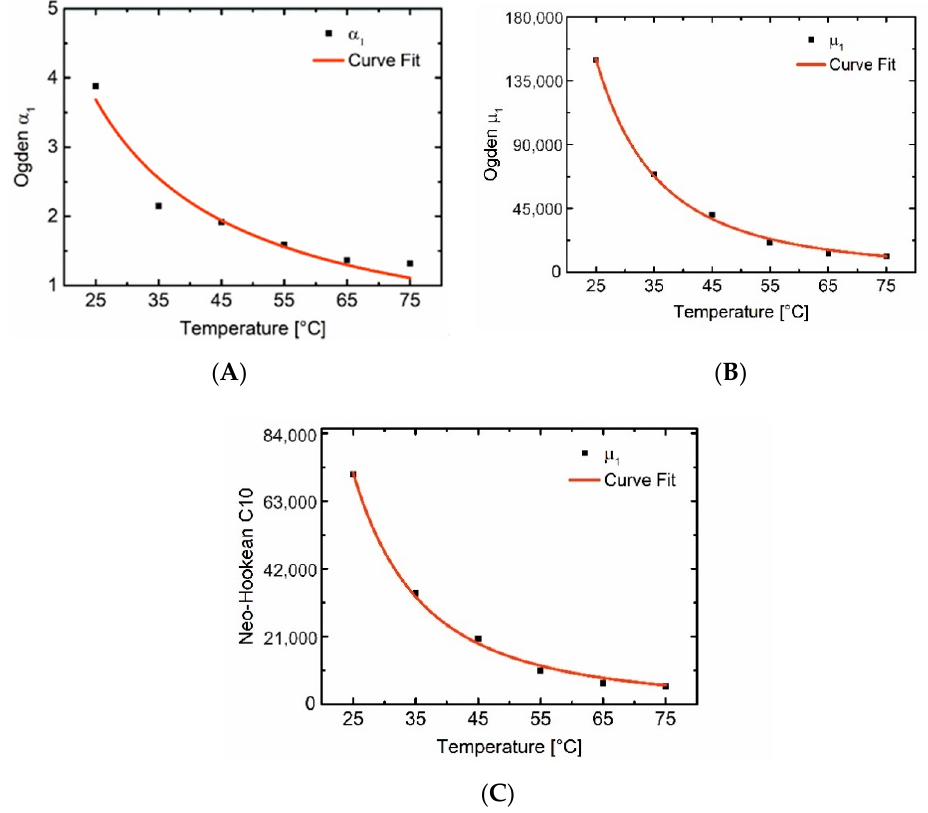
Figure 7. Temperature dependency of model parameters and the fitted power function for Ogden parameters α 1 ( A ) and µ 1 ( B ), and Neo-Hookean parameter C 10 ( C ).